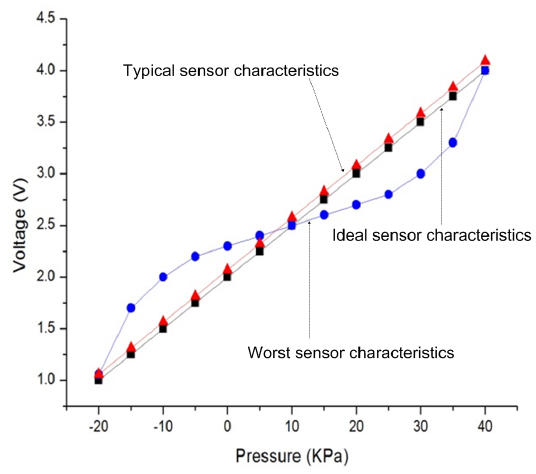
Figure 12. Test data for SSCP performance